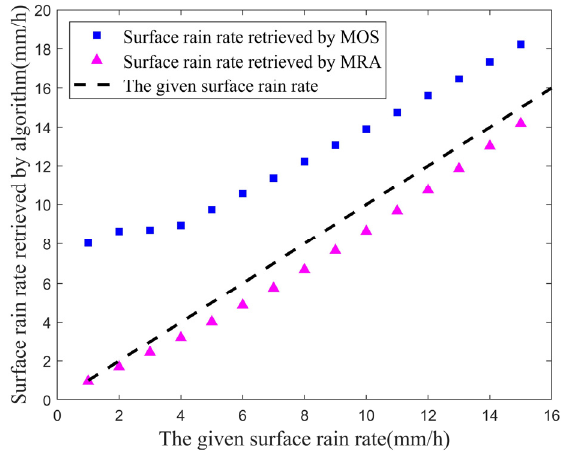
Figure 7. Surface rain rates retrieved by MRA and MOS under triangular horizontal distribution. Case 3: Assume that the horizontal distribution of all NRCS data is trapezoid and the retrieval results are shown in Figure 8. The RE of MRA ranges from 0.02 to 0.17 and the RE of MOS ranges from 0.29 to 9.76.